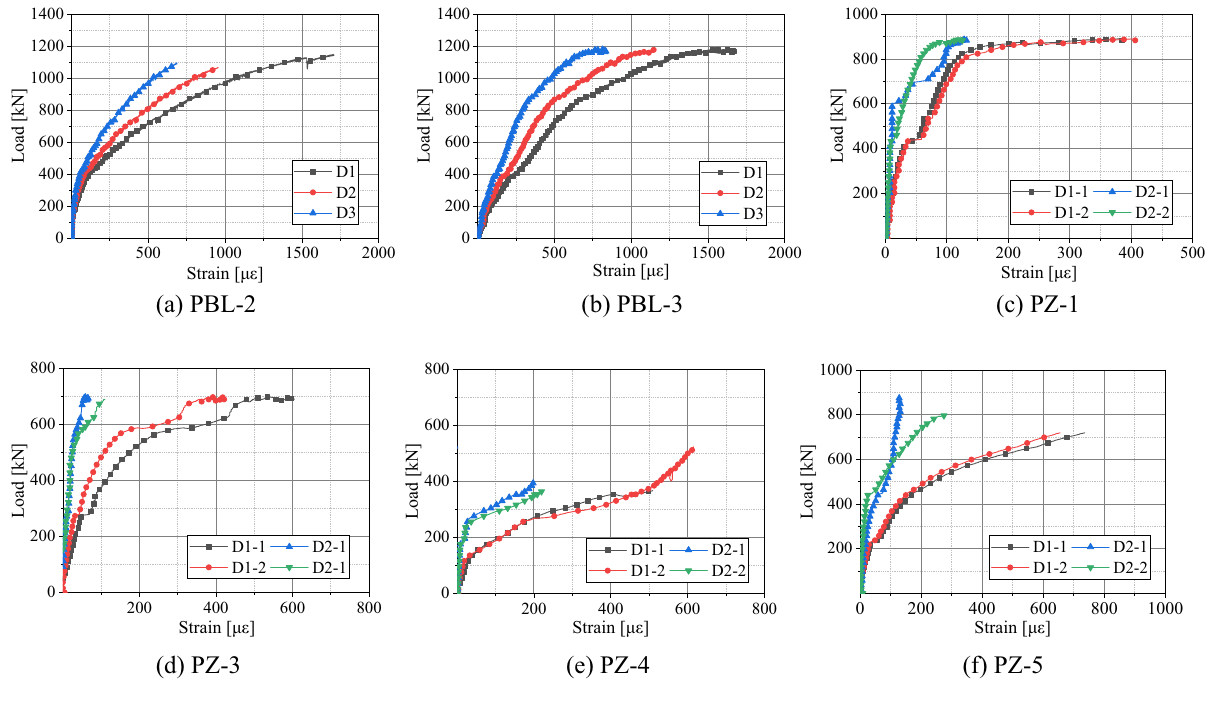
Figure 12. Load–strain curves of transversal